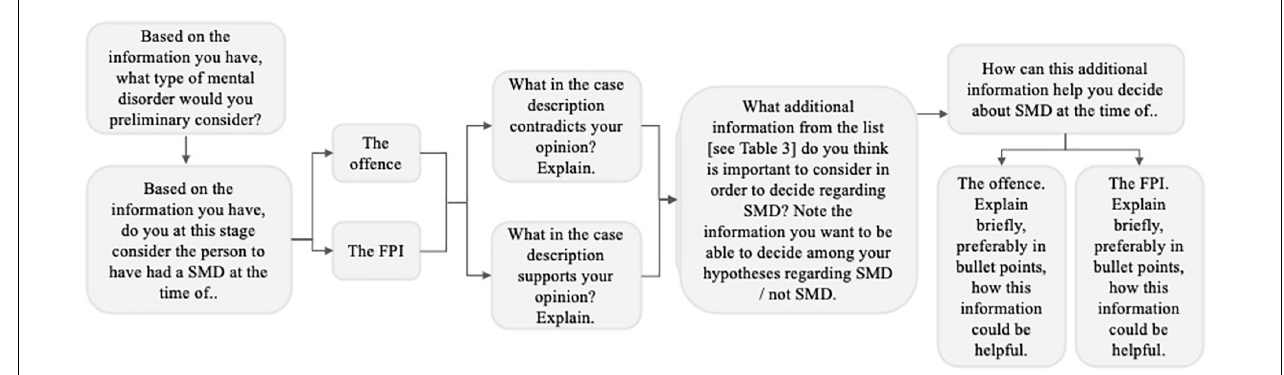
FIGURE 1 | Flowchart representing the sequence of the questions in the case vignette part (part 1) of the response form.